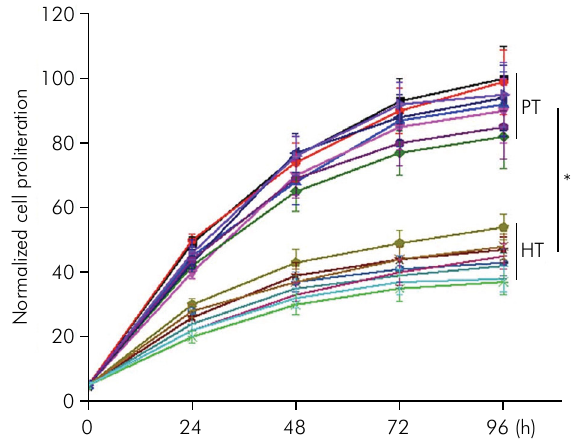
Figure 2. Proliferation of PDLSCs derived from periodontitis- affected teeth or healthy teeth.